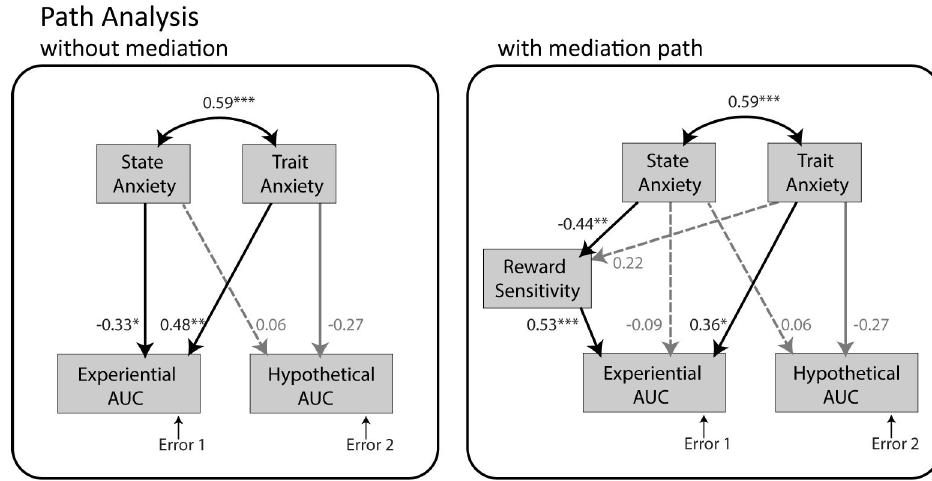
Fig 9. Results of the path analysis without mediation (left panel) and path analysis with mediation (right panel). AUC stands for Area Under the Curve, with greater AUC implying greater willingness to wait for the delayed reward. Parameter estimates are standardized with respect to the variance of state anxiety and trait anxiety. Significance level is indicated by number of stars (p < .05 � , p < .01 �� , p < .001 ��� ).